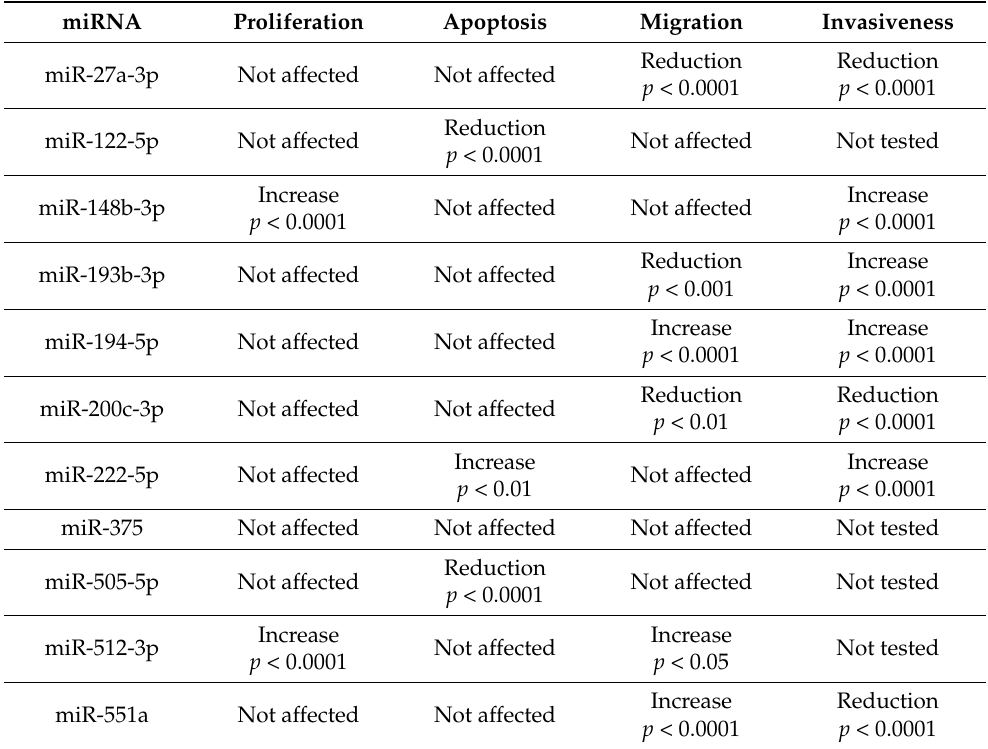
Table 1. Summary of the functional studies of miRNAs in cell proliferation, apoptosis, migration, and